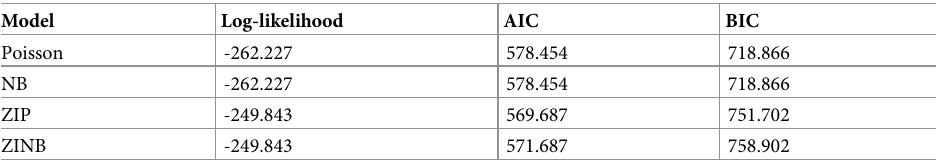
Table 4. Summary of fit